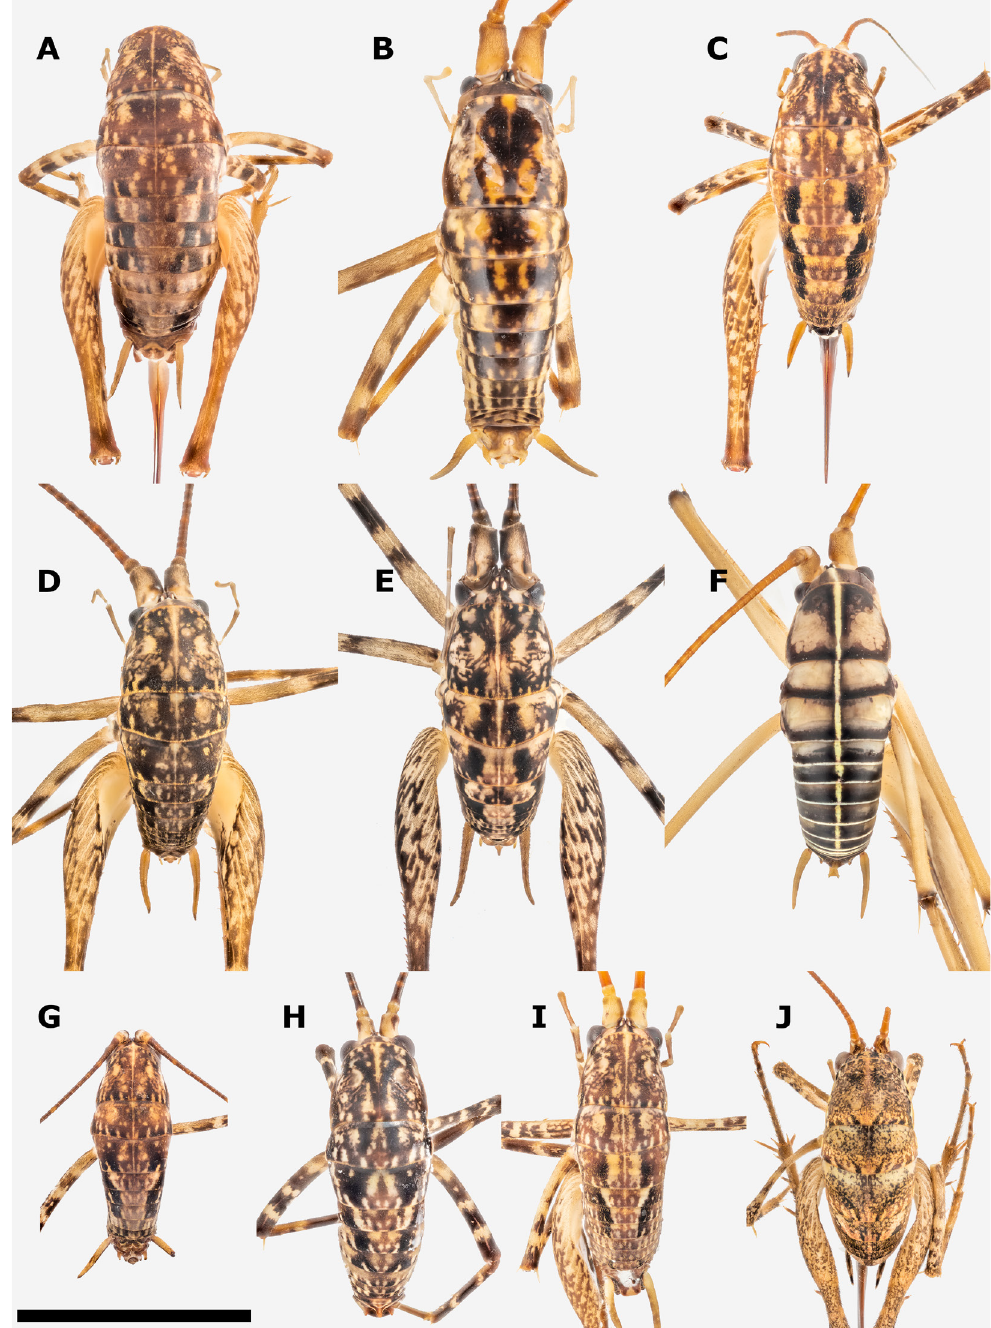
Fig. 6. Dorsal views of cave wētā in the genus Pleioplectron Hutton, 1896. A . P. simplex Hutton, 1896, adult ♀, Helicopter Hill Track, Craigieburn (MPN CW3914). B . P. thomsoni (Chopard, 1923) comb. nov., adult ♂, Claremont Bush, South Canterbury (MPN CW4115). C . P. gubernator sp. nov., adult ♀, Mt Arthur (MPN CW4056). D . P. triquetrum sp. nov., adult ♂, Hinau Track, Kaikōura (MPN